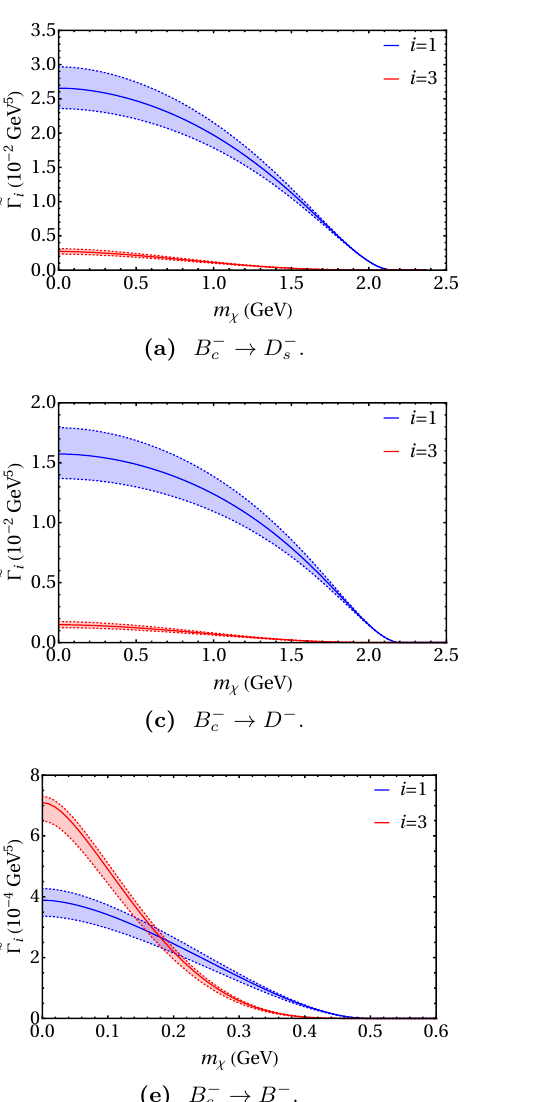
i changes with m (cid:31) in the B